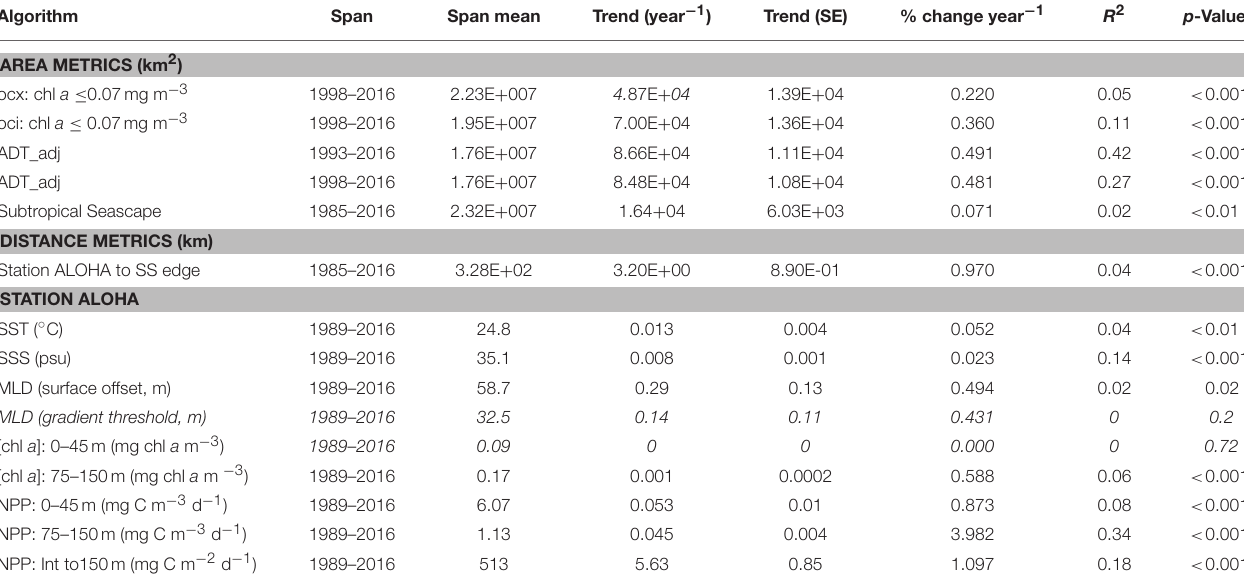
TABLE 1 | Secular trends across geographic metrics, chl a algorithms, and in situ characteristics at Station ALOHA. Algorithm